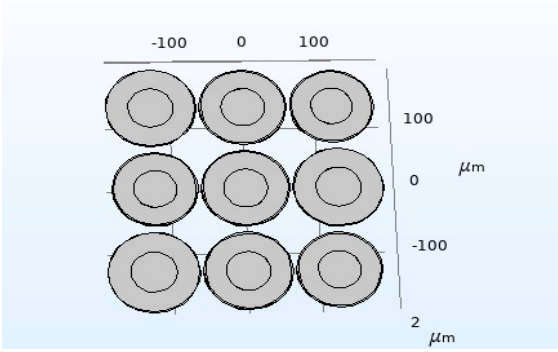
Figure 7. A CMUT model of three cell sizes.